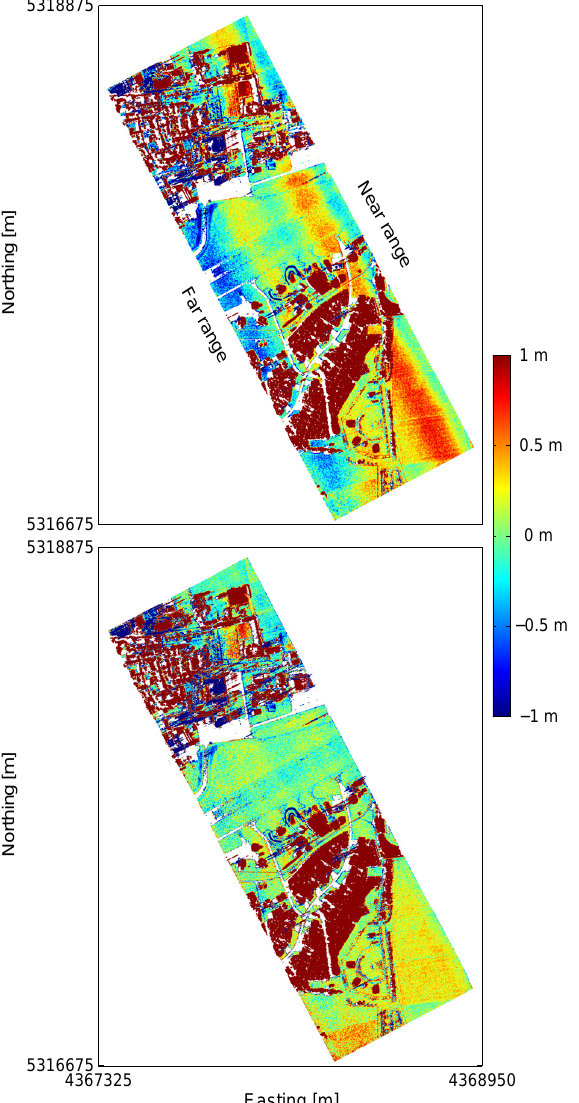
Figure 5. Height difference between the InSAR DSM calculated from acquisition M4 and an airborne laser scanning (ALS) DTM, without (top) and with (bottom) elevation angle dependent phase correction (C2F method). White areas are areas with low coherence.